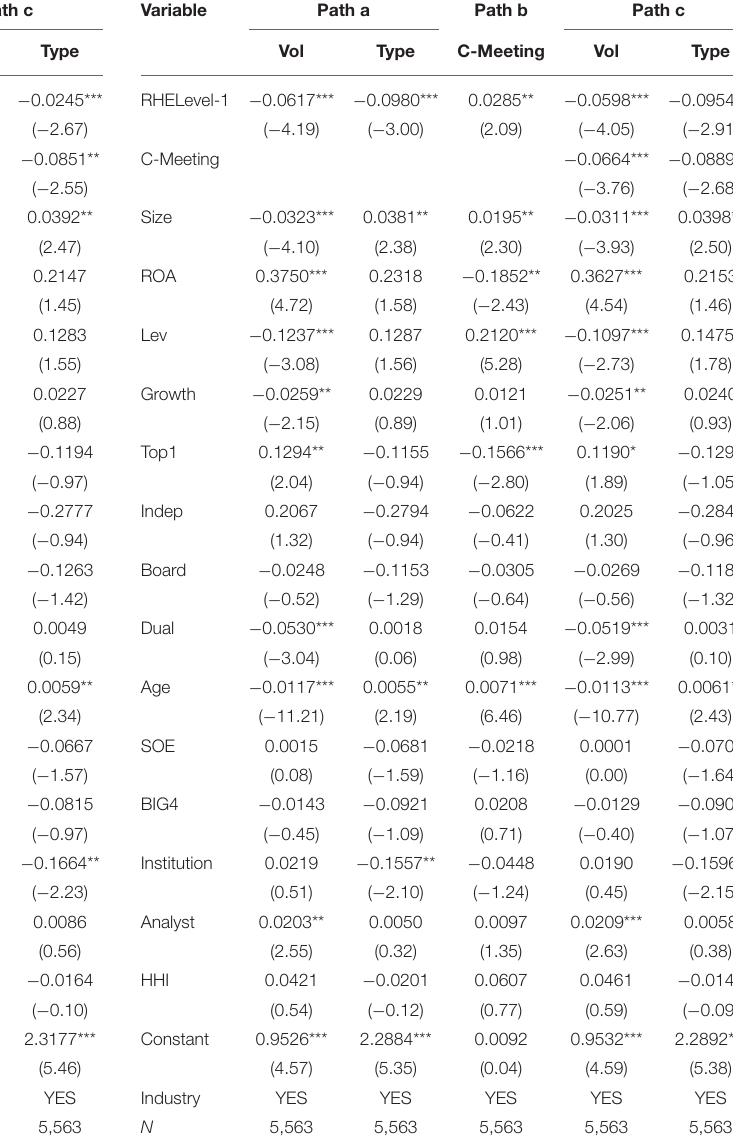
TABLE 6 | Evidence of the impact of directors’ on-site supervision restrictions (X = Num).